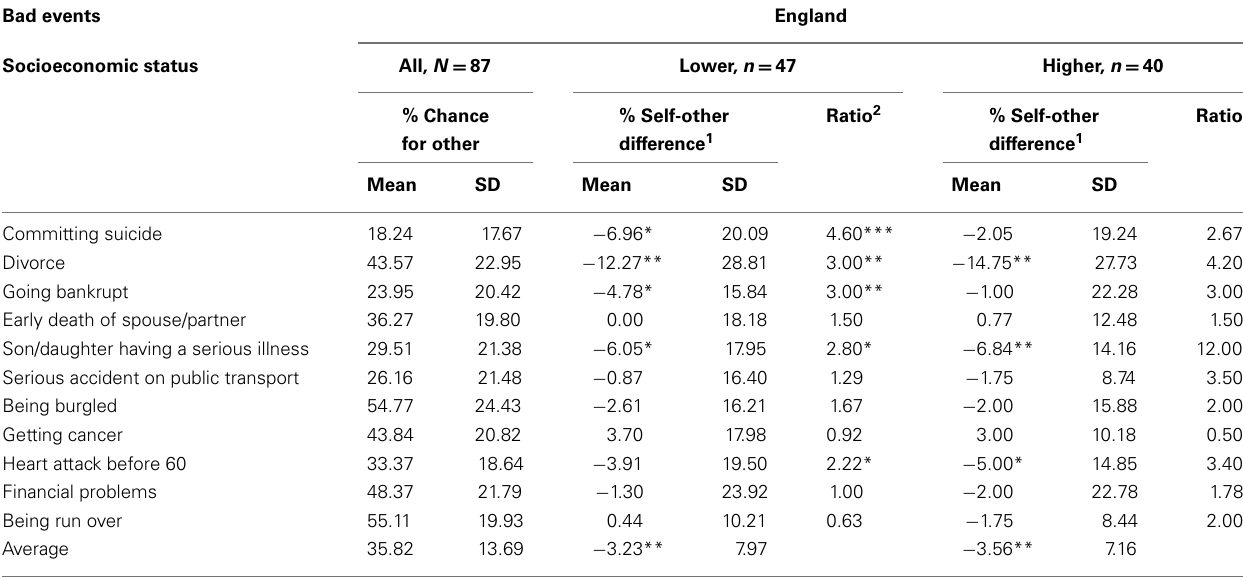
Table 3 | Bad events: comparative likelihood estimates, England. Bad